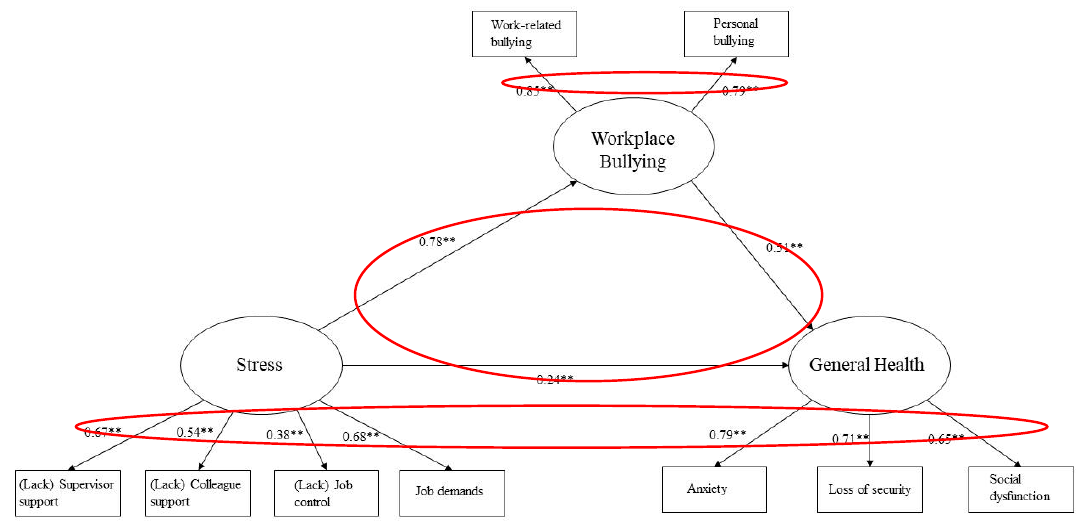
Figure 1. Standardized path coe ffi cients for the partial mediation model (** coe ffi cients are significant at p < 0.01).